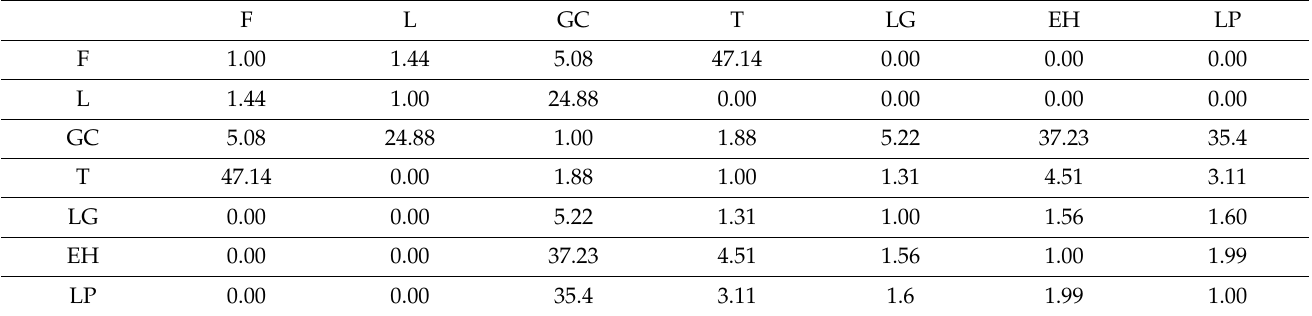
Table 12. Ratio of the correlation matrices for the best models for MIE and SIE species of the Canary Islands. The abbreviations mean: F—Fuerteventura, L—Lanzarote, GC—Gran Canaria,